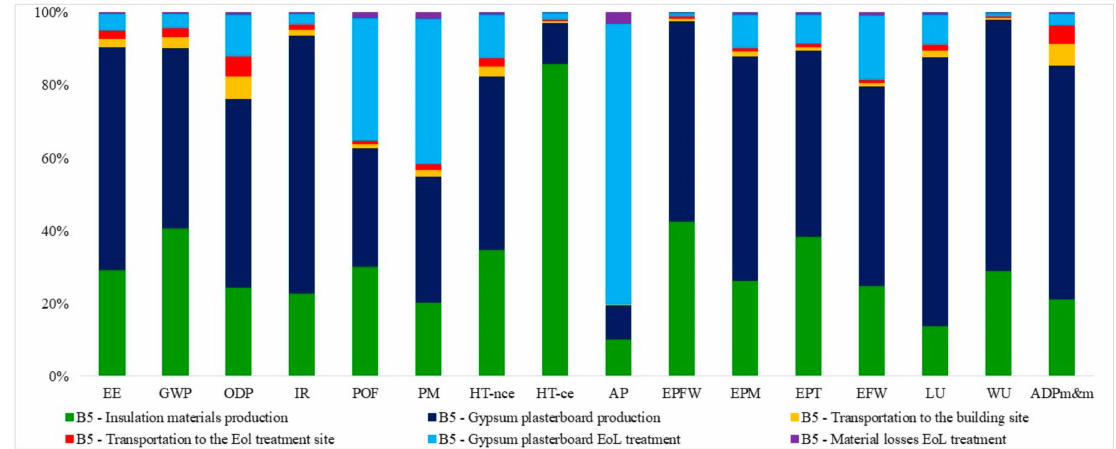
Figure A3. Contribution of the different life cycle phases to the B5 module impacts—SwS (1970–1989).